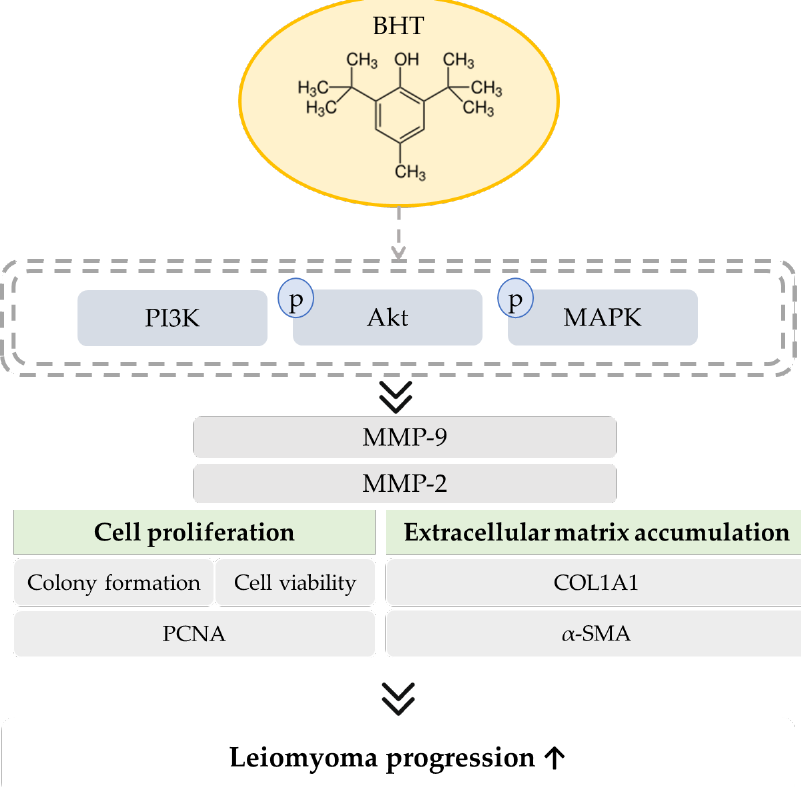
Figure 6. Schematic representation of the potential effects of BHT in leiomyoma progression. BHT could increase cell proliferative effect, modulate PI3K/Akt and MAPK signaling pathways, increase MMP enzyme and protein expression, and increase the ECM-related protein